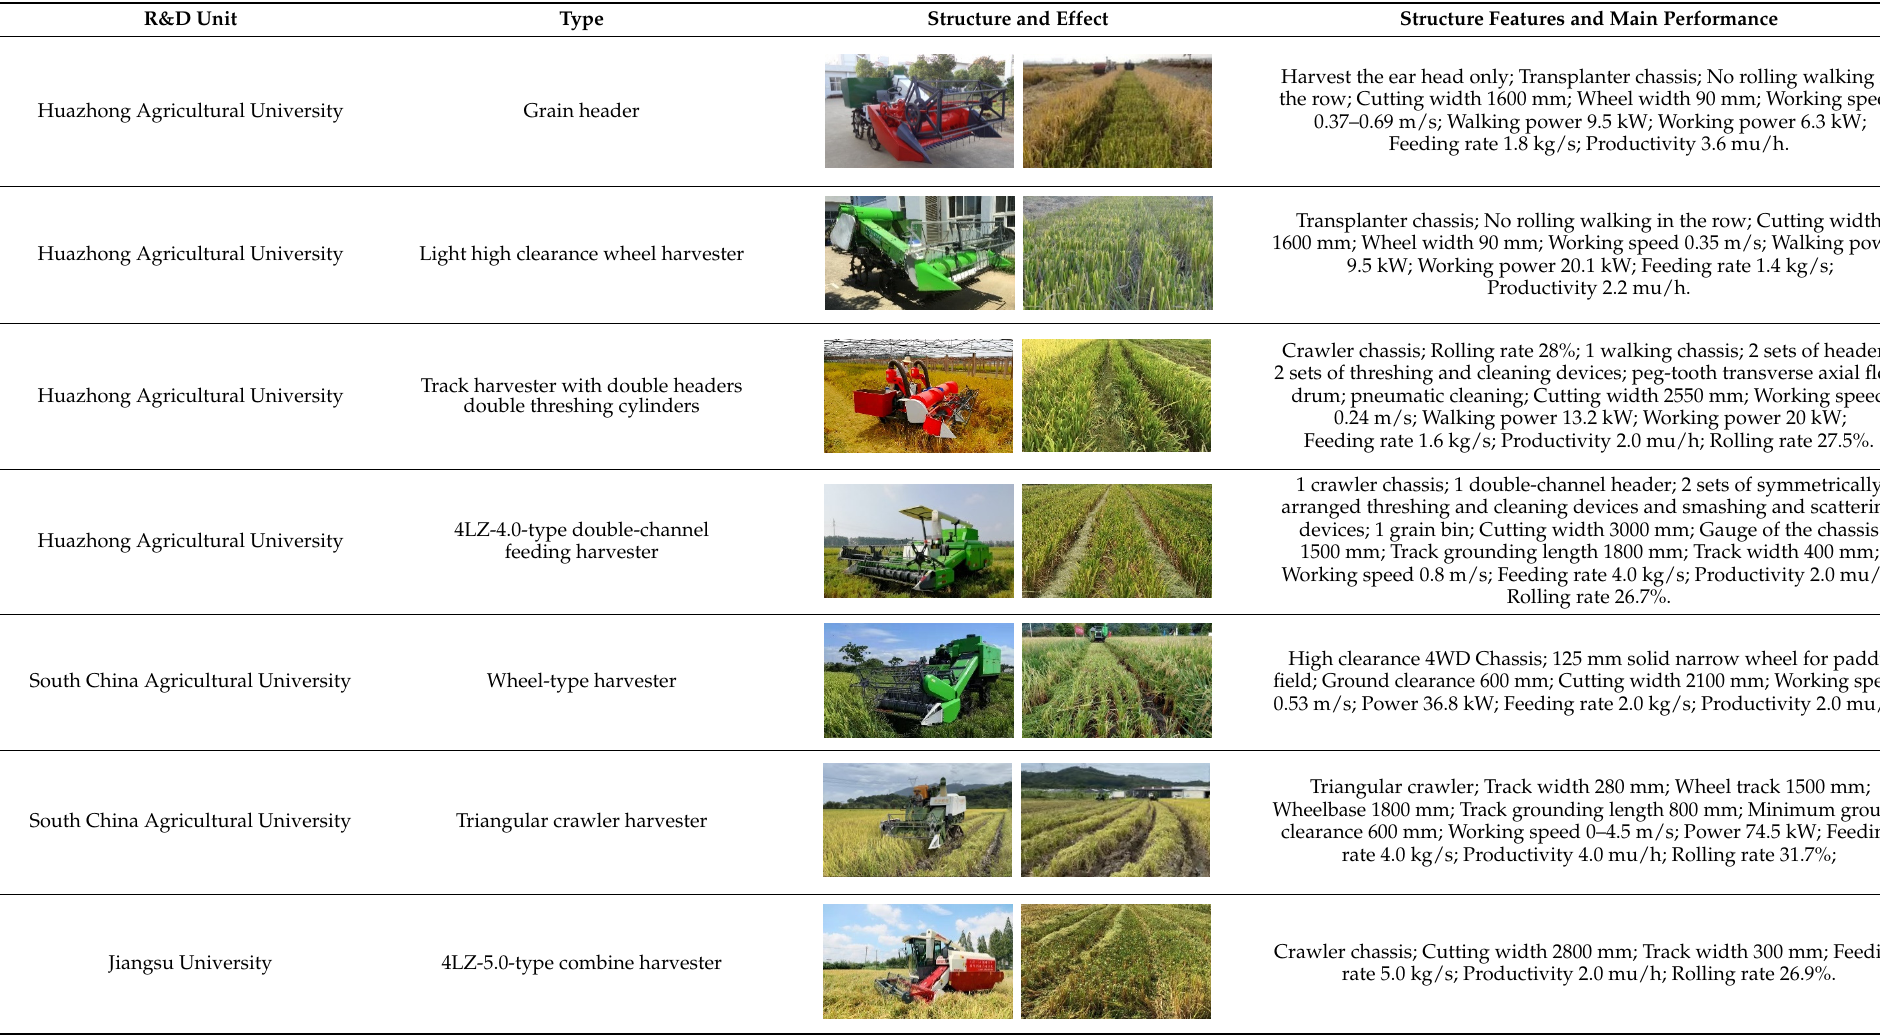
Table 2. Structure and characteristics of existing first season harvesters for ratoon rice.